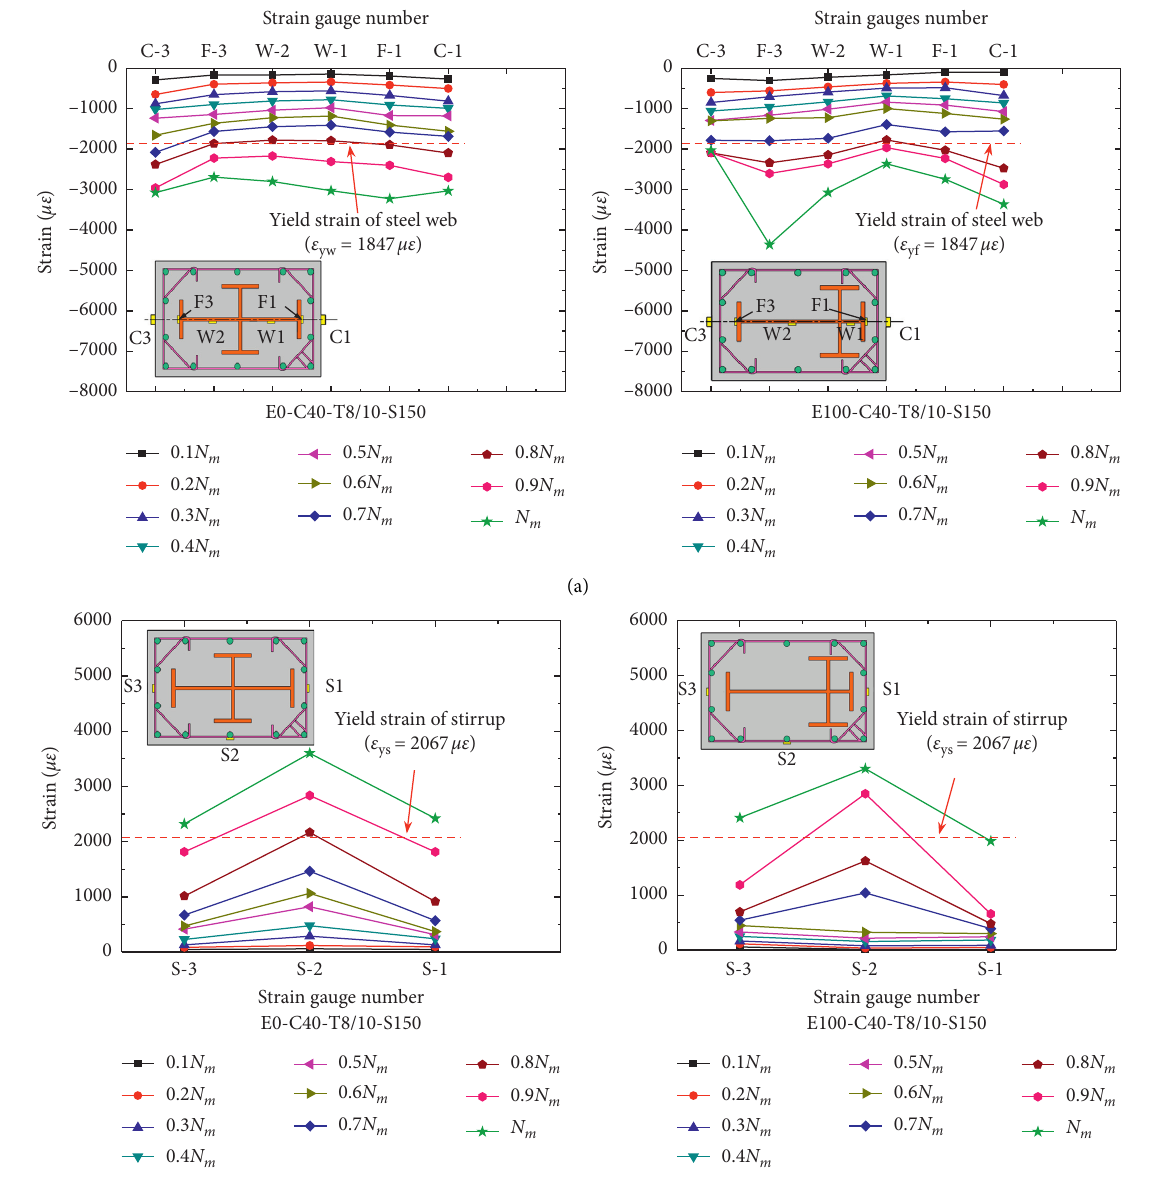
Figure 5: Strain analysis: (a) strain in the concrete and steel profile and (b) strain in the